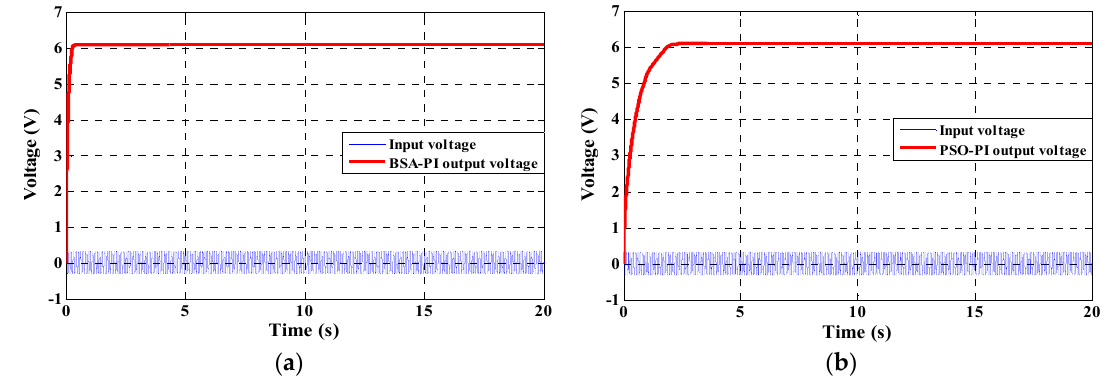
Figure 14. Simulation results of a complete PEHS utilizing a BSA-PI ( a ) and a PSO-PI ( b ) controller.